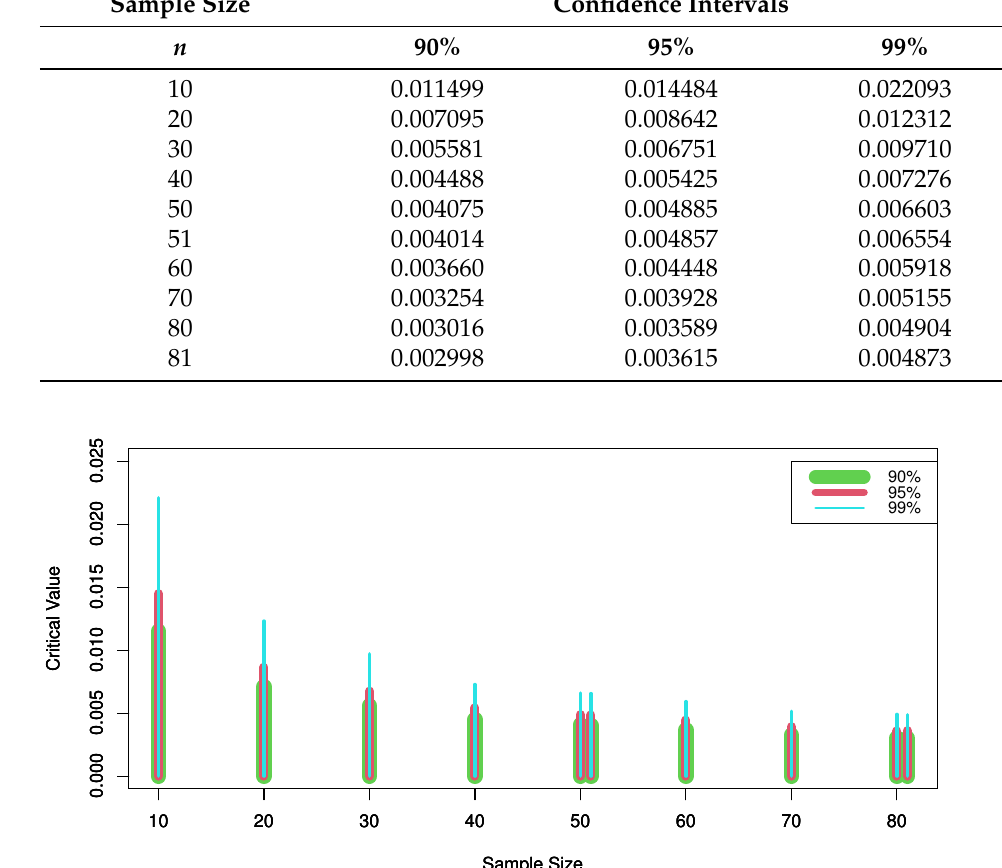
Table 4. The upper percentile of ˆ ∆ c at s = 0.99. Sample Size